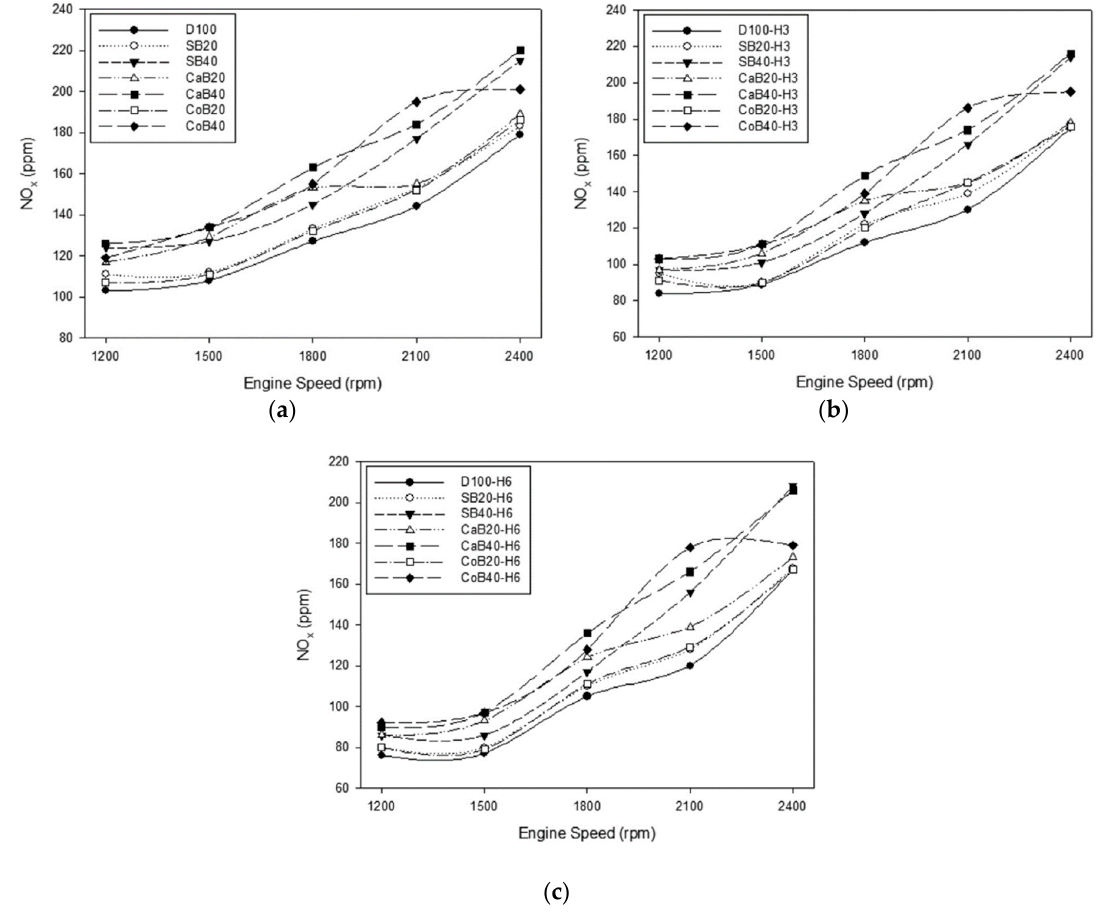
Figure 21. The emission values of NO x : ( a ) without hydrogen; ( b ) with H3; and ( c ) with H6 addition [72]. The emission values increased at higher speeds in all test conditions. Figures are reprinted with permission from publisher.